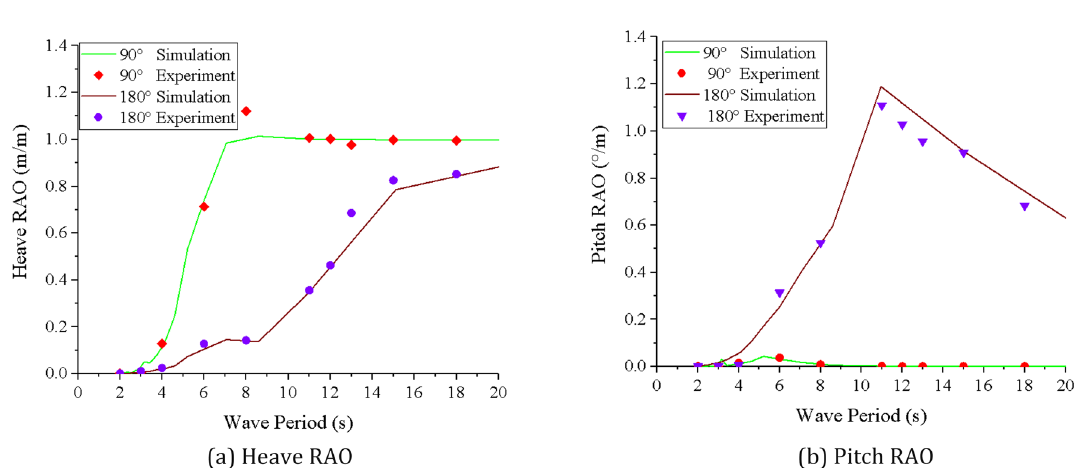
Figure 6. RAO curves of mining vessel at different wave directions. ( a ) Heave RAO, ( b ) Pitch RAO (created by Origin 2017 software, URL: https:// www. origi nlab. com/).